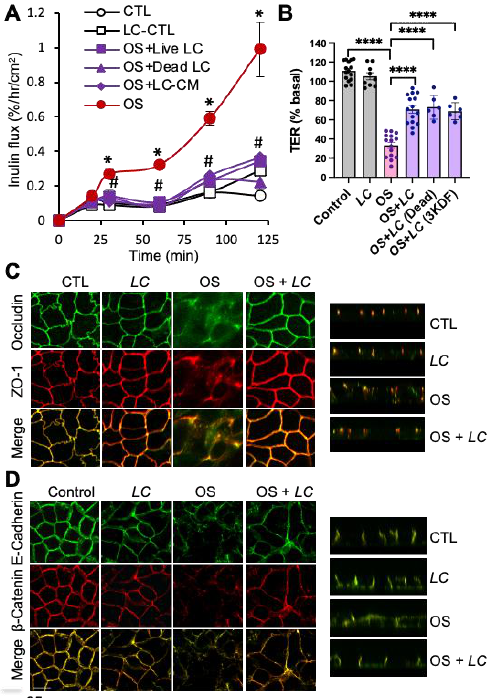
Figure 1. L. casei prevents osmotic stress-induced tight junction disruption and barrier dysfunction in Caco-2 cell monolayers. ( A , B ) Caco-2 cell monolayers (13–15 days post-seeding) were pretreated with (□, ■ ) or without ( ○ , ●) L. casei (LC; 10 5 cells/mL) for 30 min followed by osmotic stress (OS) by incubation in hyperosmotic medium (●, ■ ). In some groups, dead L. casei ( ; 10 5 cells/mL) or 3KDF faction of L. casei ( ⧫ ; 5 μL/mL) instead of live L. casei . Inulin flux ( A ) and TER ( B ) were measured at varying times. The control (CTL) group received similar treatments in the iso-osmotic medium. Values are mean ± SEM (n = 3–6 from two experiments for the time course of inulin flux; n = 9–15 from five experiments for TER measured at 60 min after osmotic stress. In panel A, * indicates the OS values (●) that are significantly ( p < 0.05) different from the corresponding CTL values ( ○ ); # indicates that OS + LC values ( ) are significantly ( p < 0.05) different from corresponding OS values (●). In panel B, asterisks represent significant difference between indicated groups; * = p<0.05, **** = p<0.0001. ( C , D ) At 90 min OS treatment, cell monolayers were fixed and co-stained for occludin and ZO-1 ( C ) or E-cadherin and β-catenin ( D ). X-Y and Z-section fluorescence images were captured by confocal microscopy.